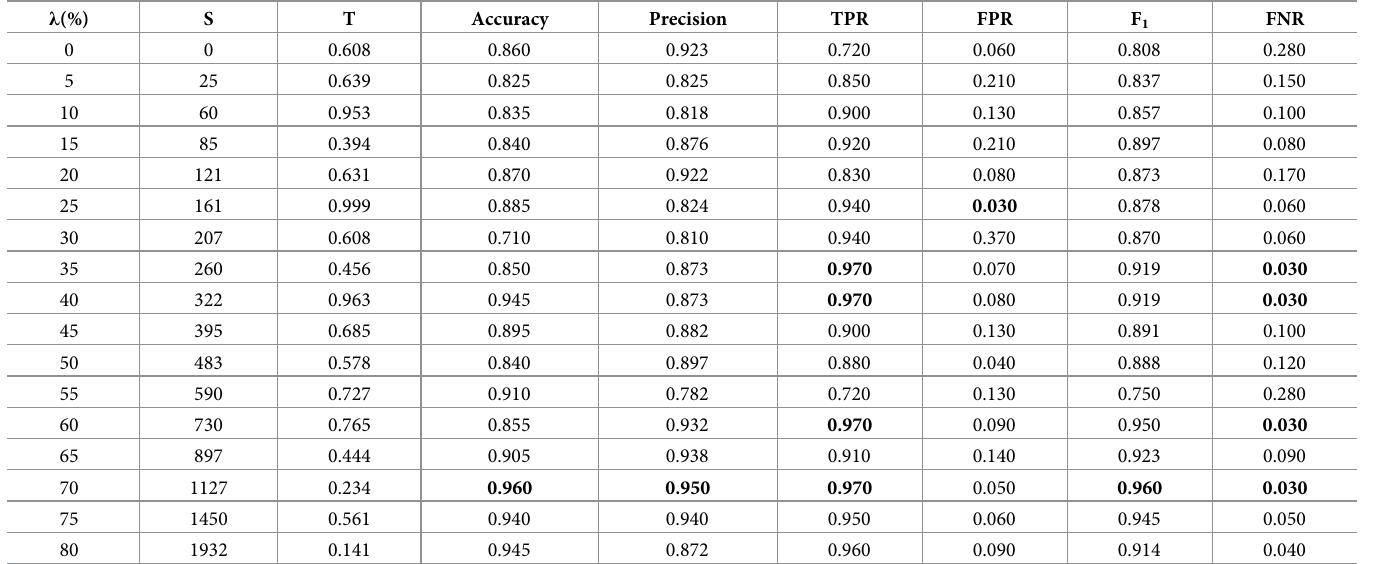
Table 6. Sensivity analysis results.